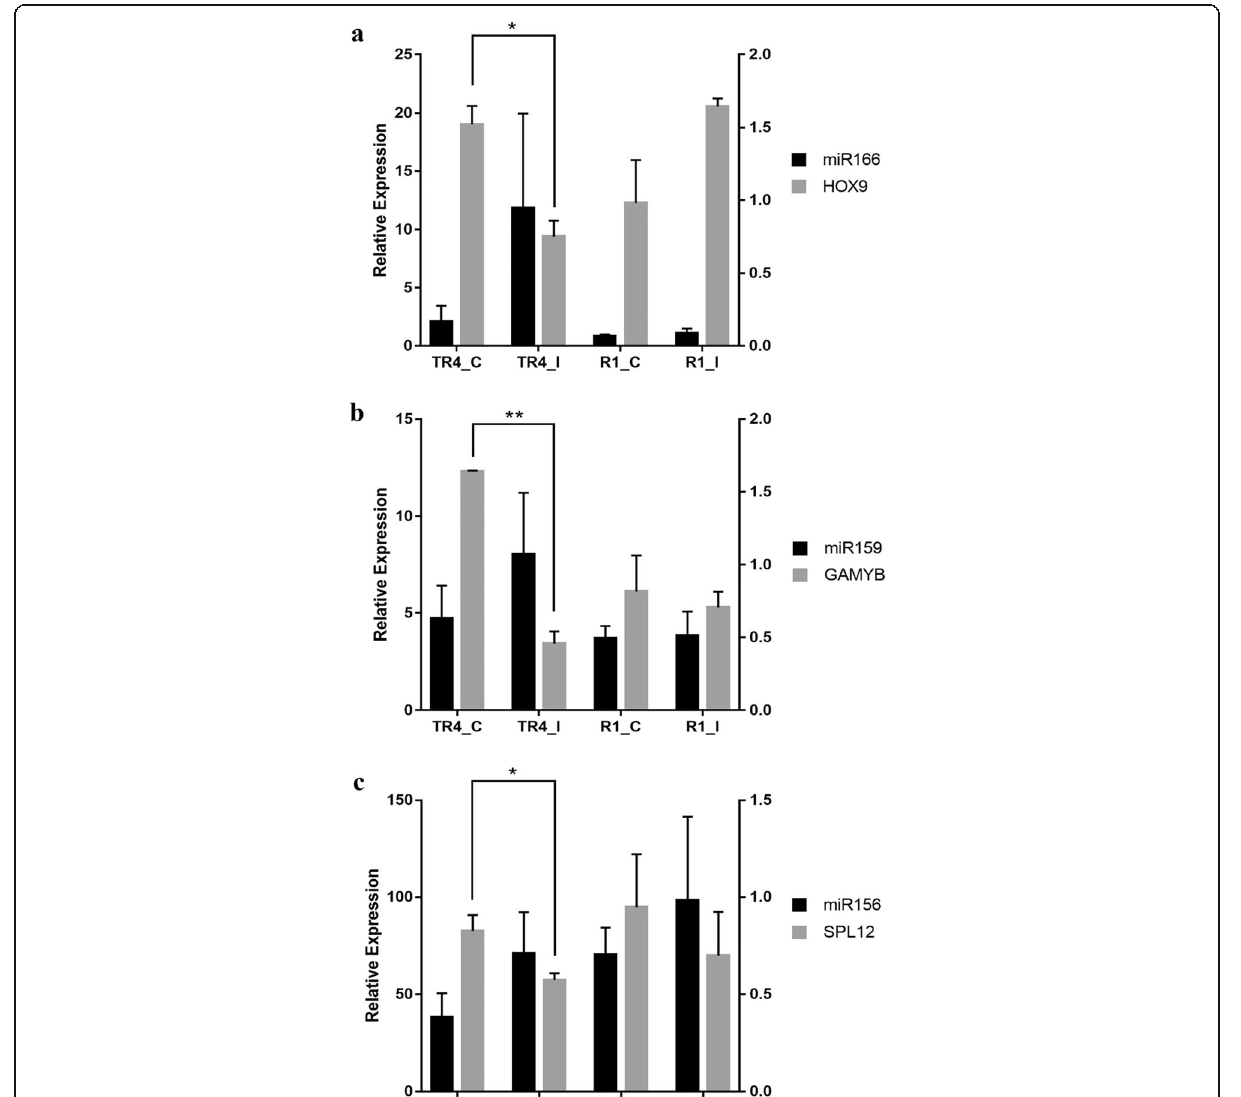
Fig. 6 qRT-PCR validation of selected miRNAs and their target genes. Negative-correlation of the expression between miR166, miR159, miR156 and their target genes was observed in TR4_C and TR4_I. a miR166 and its target gene, HOX9 ( Homeobox-leucine zipper protein 9 ) (GSMUA_Achr5T18530_001). b miR159 and its target gene, GAMYB (GSMUA_Achr7T21560_001). c miR156 and its target gene, SPL12 ( Squamosa Promoter Binding Protein-like 12 ) (GSMUA_Achr10T02970_001). One-way analysis of variation (ANOVA) was used to determine the significant difference of the target gene expression between groups. One asterisk represents significant difference with P -value< 0.05; two asterisks represent significant difference with P -value<